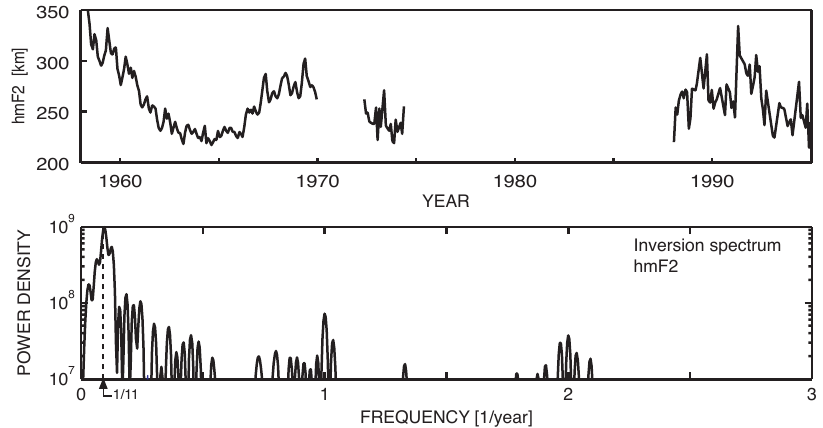
Fig. 10. Same as Fig. 7 for the F-layer maximum altitude hm F2 obtained by means of real height analysis of individual ionograms. The data contains large